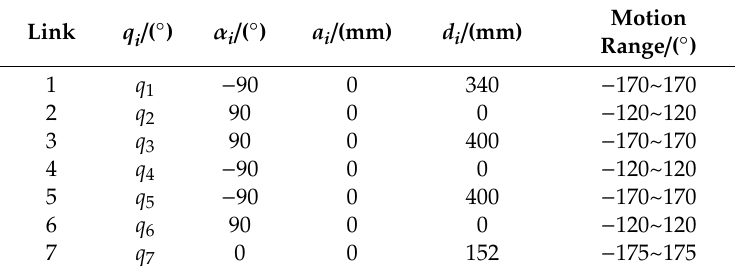
Table 1. DH (Denavit & Hartenbrtg) parameters of the